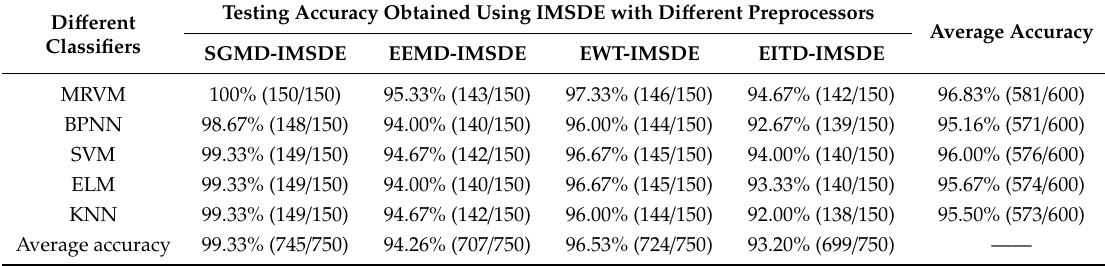
Table 7. Diagnosis results of combining various classifiers with IMSDE containing di ff erent preprocessors.